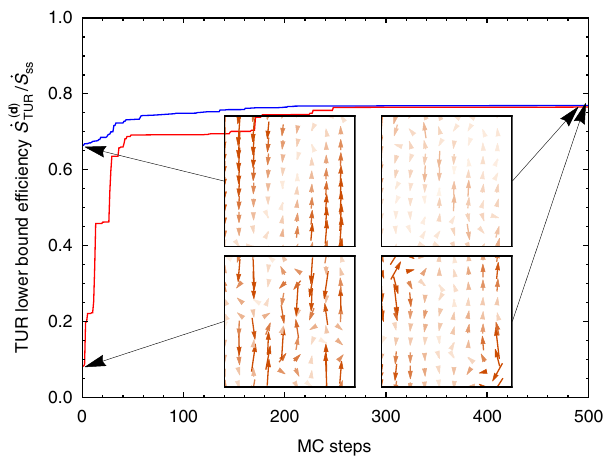
Fig. 5 Monte Carlo sampling for maximally informative currents. We seek a weighting vector fi eld d such that the TUR bound is as close to the true entropy production rate as possible. Starting either with d = F (blue curve) or with a random vector fi eld (red curve), a Markov chain Monte Carlo procedure was used to change d in search of a higher _ S ð d Þ Monte Carlo sampling discovers diverse ways to yield a similar maximal value of the TUR ratio, suggesting that while the optimization problem is not dominated by a single basin, competitive near-optimal solutions can be discovered from a variety of starting